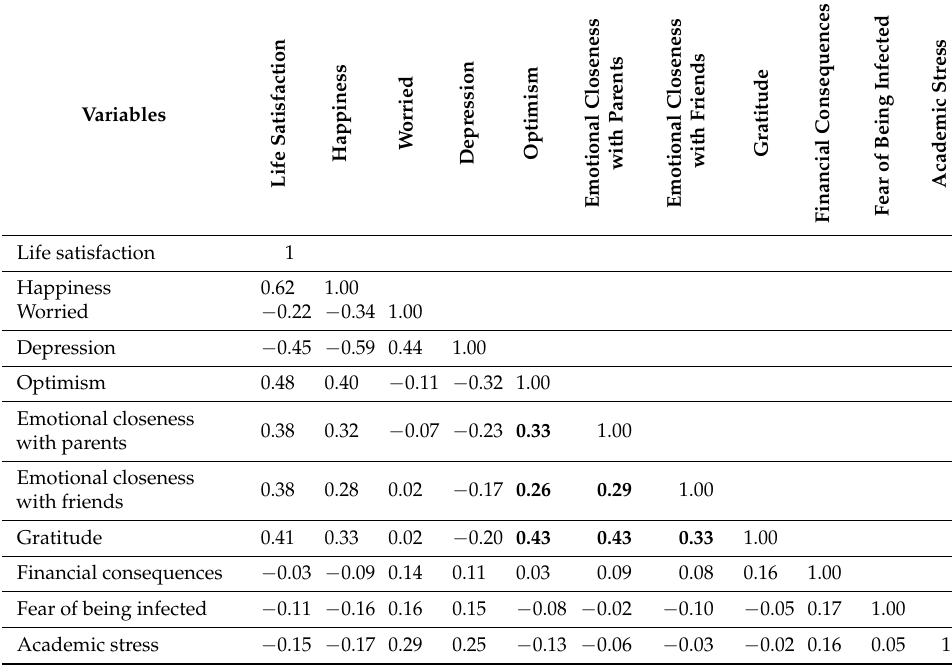
Table 2. Variables correlations.